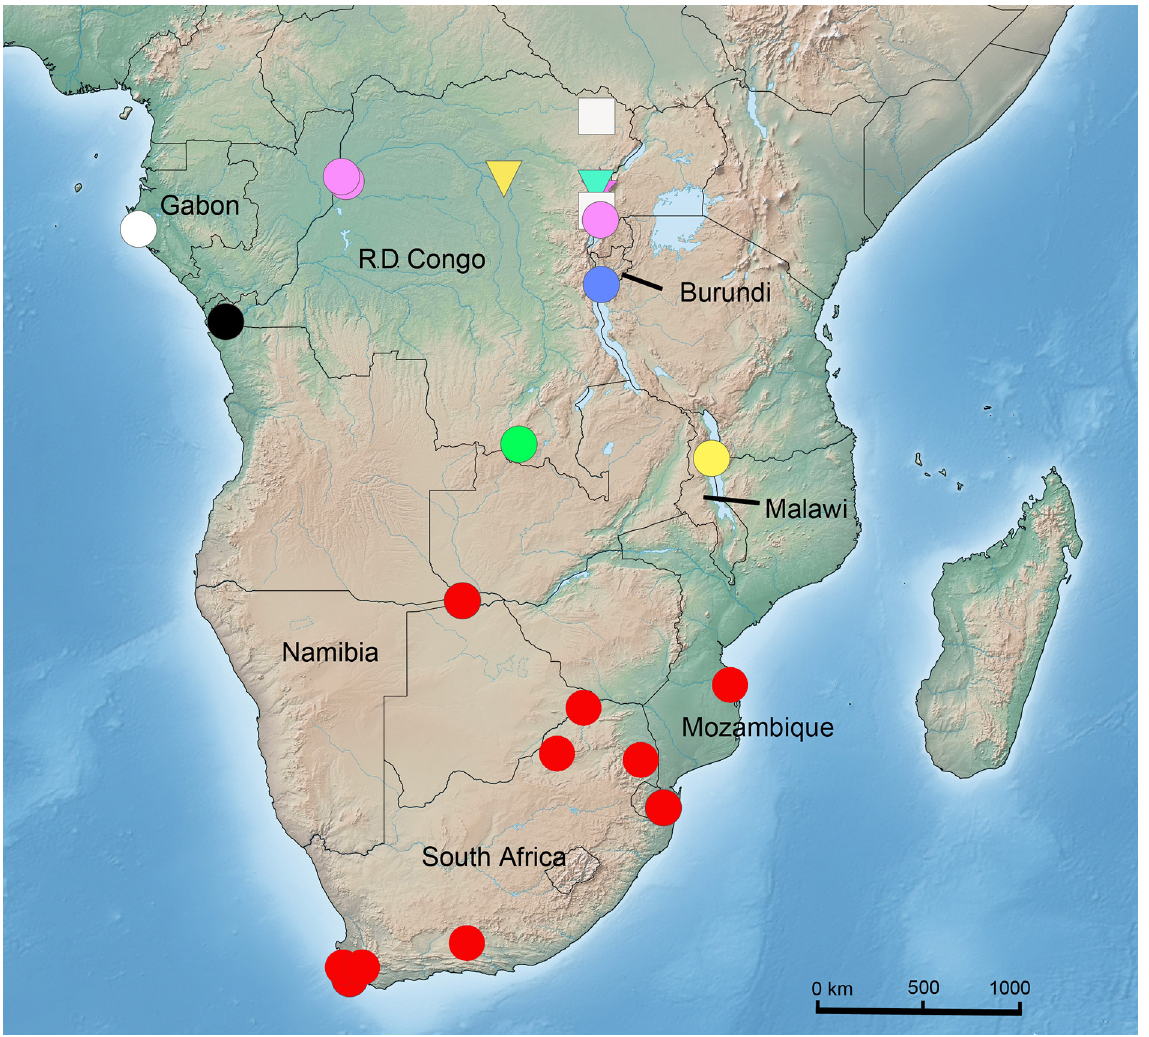
Fig. 40. Distribution map of species of Andromma Simon, 1893 (circles if shape of symbol not specified). A. anochetorum Simon, 1909 (white), A. deogratias sp. nov. (blue), A. dicranobelos sp. nov. (black), A. ghesquierei sp. nov. (fuchsia), A. heligmos sp. nov. (green triangle), A. juakalyi sp. nov. (yellow triangle), A. katangensis sp. nov. (green), A. ophiophagum sp. nov. (white squares), A . raffrayi Simon, 1899 (red) and A. velum sp. nov.